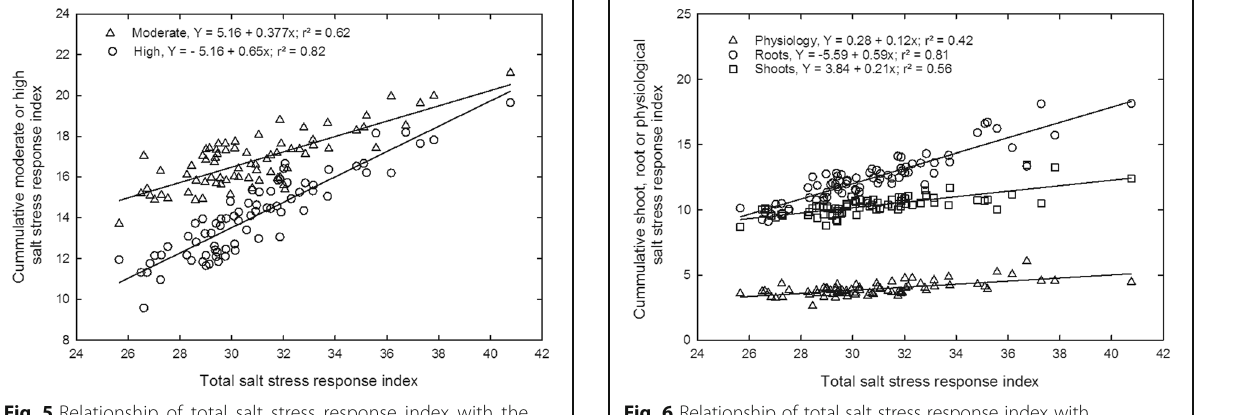
Fig. 6 Relationship of total salt stress response index with cumulative moderate and cumulative high salt stress response indices for all the rice genotypes. Measurements were taken 37 days after